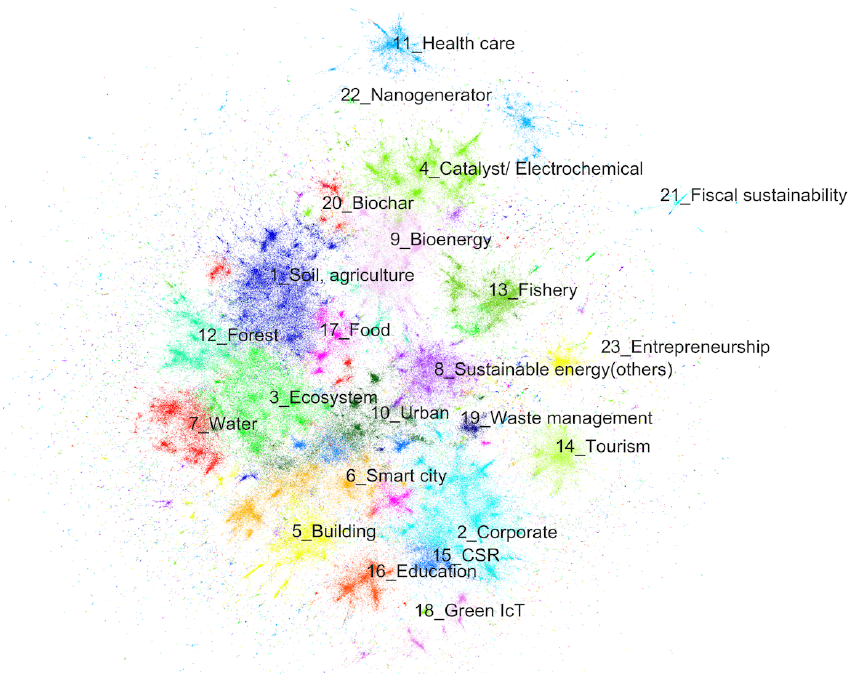
Figure 2. Map of sustainability